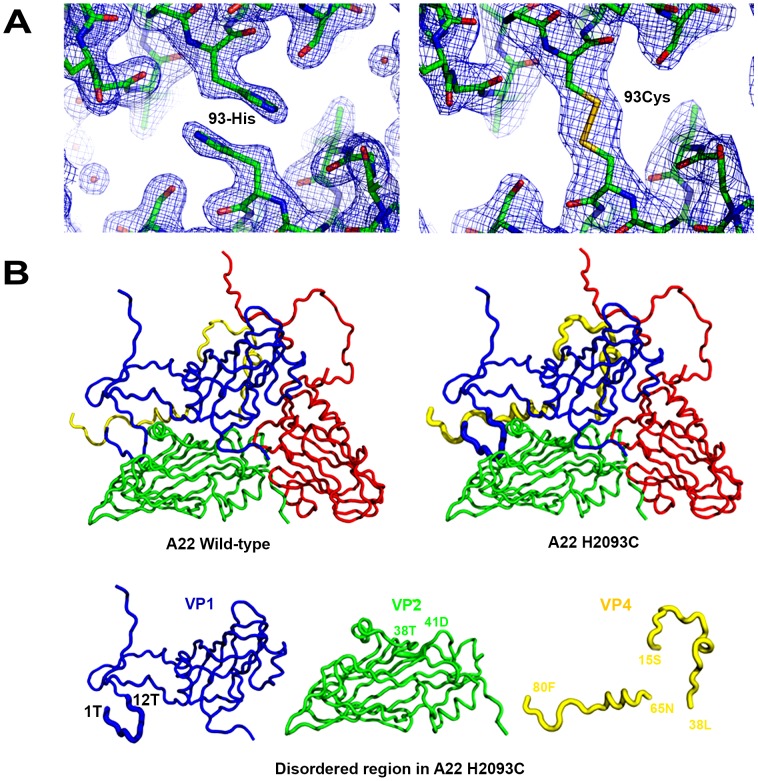
Structure analysis of A22-wt and A22-H2093C empty capsids.(a) The electron density map for A22-wt (left panel) presents the expected histidine side chains for VP2 residue 93 whereas the map for A22-H2093C (right panel) shows the disulphide density at the two-fold axis between pentamers. (b) Side by side ribbon drawings of the recombinant empty capsid protomers and beneath the individual VP1, 2 and 4 proteins. There was no difference between the A22-wt and A22-H2093C capsids on the exterior surface; significant disorder observed on the interior of the A22-H2093C capsids is shown as thickened lines and corresponds to the N terminus of VP1 (residues 1 to 12) and VP4 (residues 15 to 38 and 65 to 80) located near the 3-fold axes. To a lesser extent residues 38–41 in VP2 were also disordered.